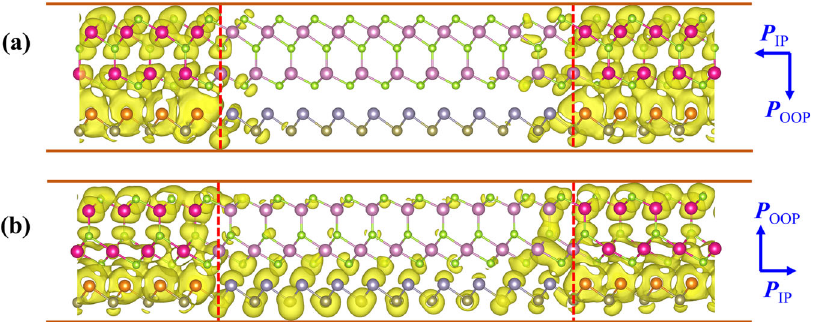
Fig. 6 The partial charge densities. The Partial charge densities for the designed FTJs in the energy range from E F − 0.1 eV to E F for a P ↓ and b P ↑